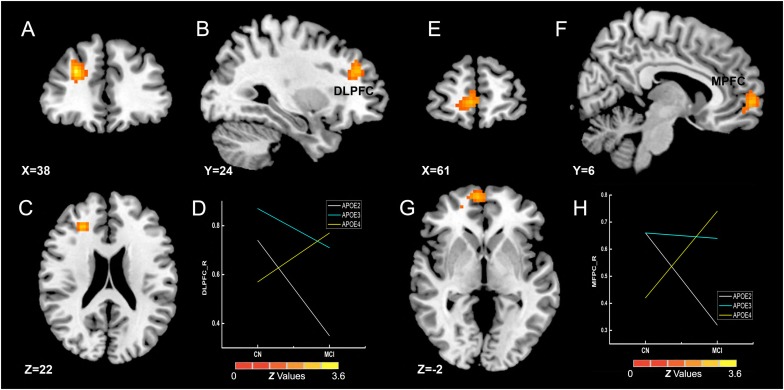
Interactive influence of diagnosis and APOE genotype on gFCD (p < 0.005; α < 0.001; 3dClustSim corrected). (A–C,E–G) Interactive influence of diagnosis and APOE genotype on the brain functions in the right DLPFC and MPFC. (D,H) The diagrams illustrate the interactive influence of diagnosis and APOE genotype in the DLPFC and MPFC. Compared to the CN group, the gFCD values in the DLPFC and MPFC was higher in patients with MCI who had the APOE ε2+ genotype and was lower in those who had the APOE ε4+ genotype; no significant alteration was noted in the MCI group with the APOE ε3ε3 genotype. gFCD, global functional connectivity density; CN, cognitively normal; MCI, mild cognitive impairment; DLPFC, dorsolateral prefrontal cortex; MPFC, medial prefrontal cortex.